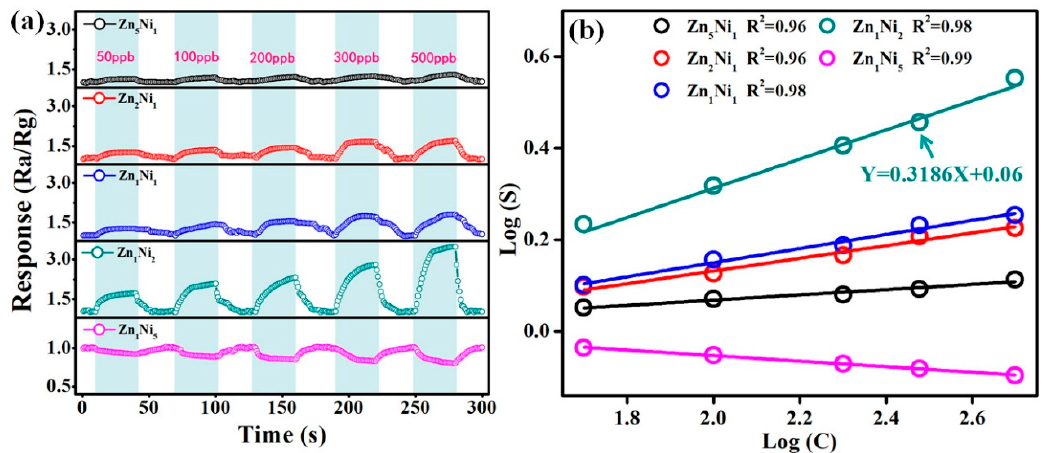
Figure 8. ( a ) Real-time response curves of 3D n -ZnO/ p -NiO sensors toward the low NH 3 concentrations from 50 to 500 ppb at 280 °C . ( b ) Corresponding response of linear relationship with logarithmic forms of n -ZnO/ p -NiO sensors. Sensors 2020 , 20 , x FOR PEER REVIEW